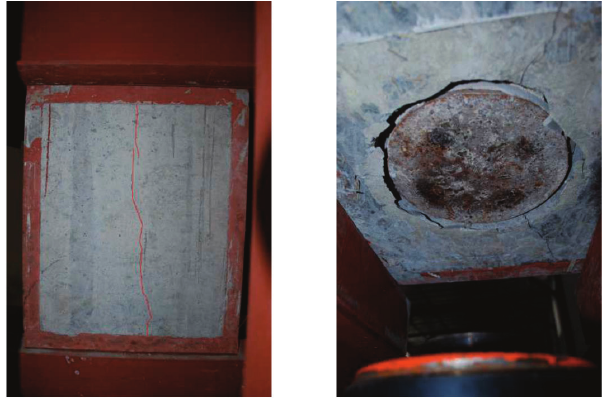
Fig. 4. Loading of specimens